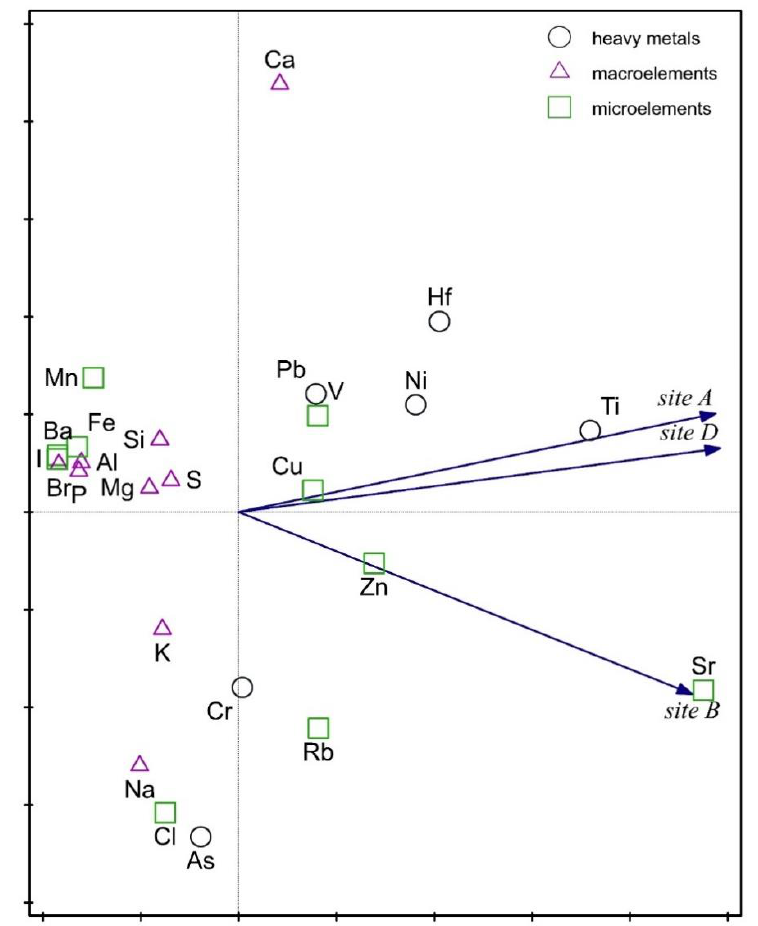
Figure 7. Principal Component Analysis (PCA) showed a composition data of the Ulva elements from the studied sites. The first axis explained 93% of the data variation. The vectors indicate the sites and the symbols elements divided into chemical groups.